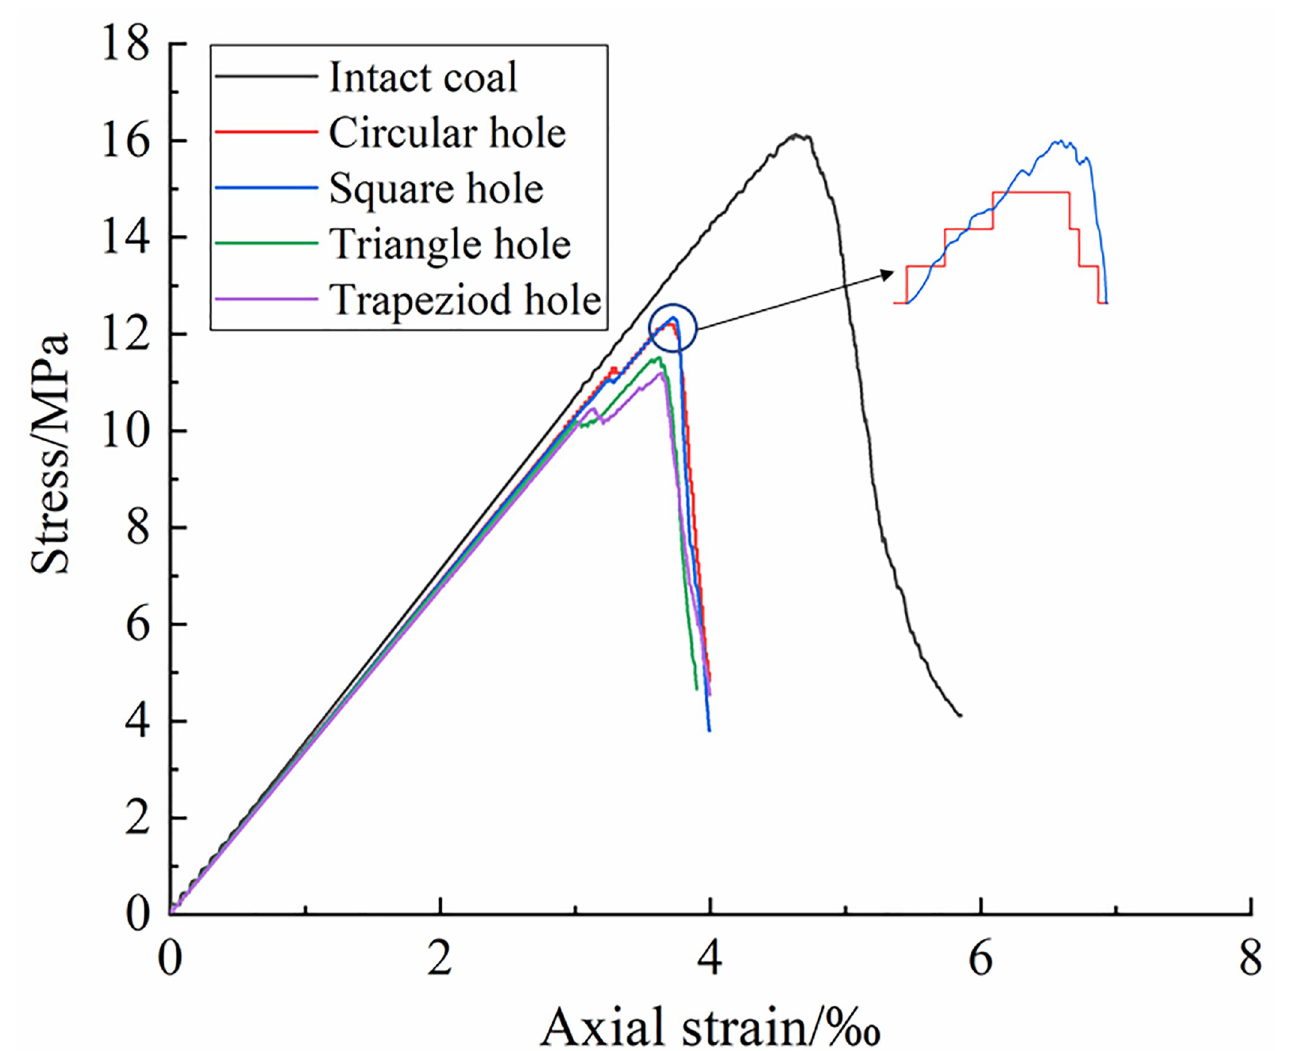
Fig 4. Stress-strain curves of coal and rocks with hole defects of different shapes.